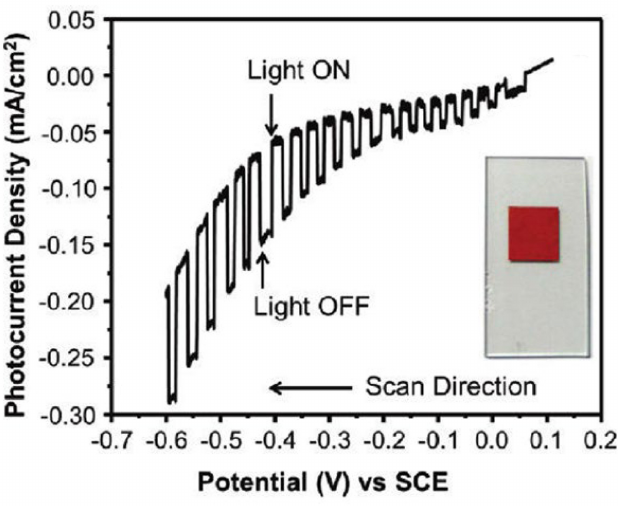
Figure 5. The current-potential curve in an aqueous 0.5 M Na 2 SO 4 solution (pH 6.3) under chopped visible-light irradiation ( λ > 420 nm) for a CuNbO 3 electrode. Insert shows a photograph of the CuNbO 3 film on FTO glass. Reproduced with permission from [79]. Copyright 2011, American Chemical